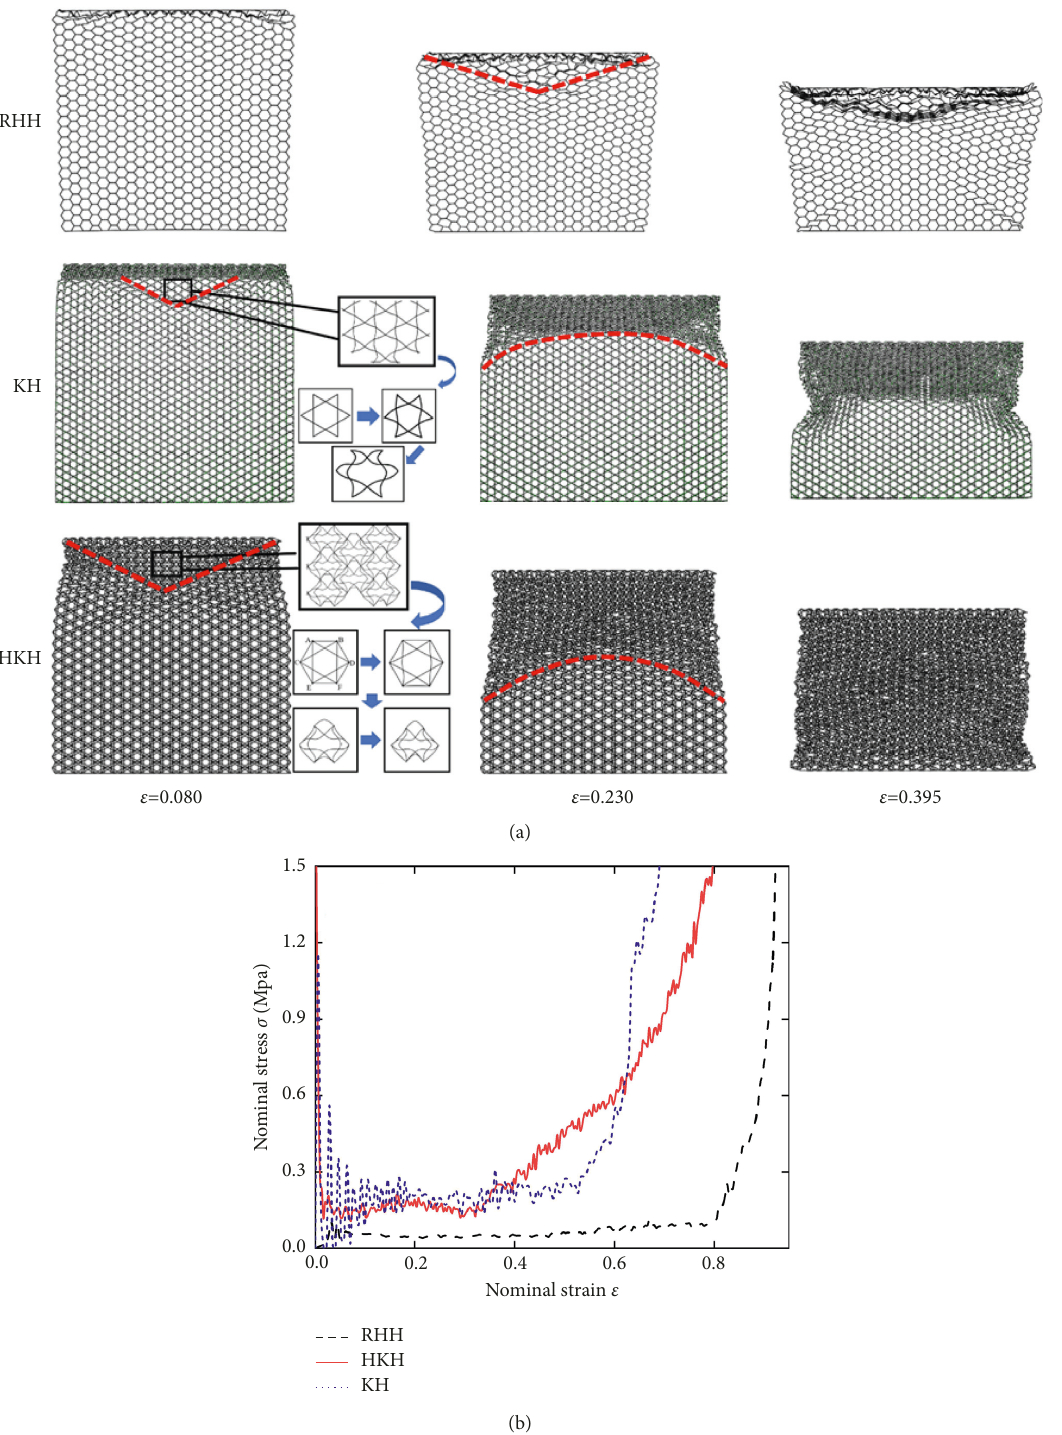
Figure 6: Dynamic crushing behaviors of three honeycombs under an impact velocity of V � 10m/s: (a) deformation maps and (b) strain- stress